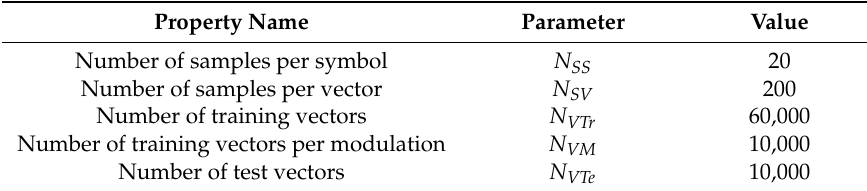
Table 1. Format of the data used for